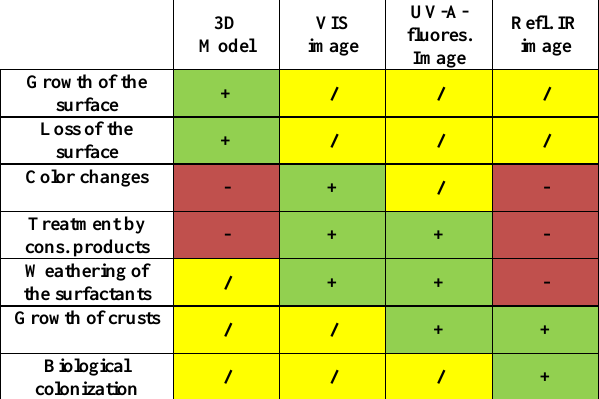
Table 10. Suitability (+), limitations (/) and disadvantages (-) of the single NDTs in an opto-technical monitoring